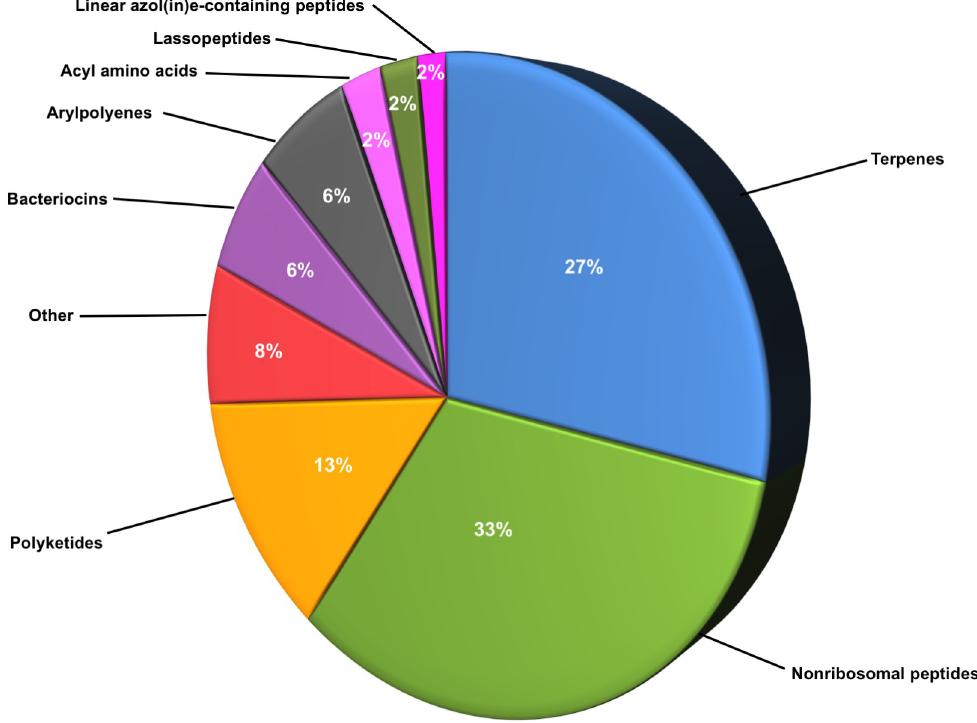
Fig 5. Percentage of genes dedicated to producing various classes of secondary metabolites. Pi chart of antiSMASH- annotated BGCs involved in secondary metabolite production in all EB-90M DNA samples (sediment and water). Classes that represent < 2% of 449 BGCs are classified as